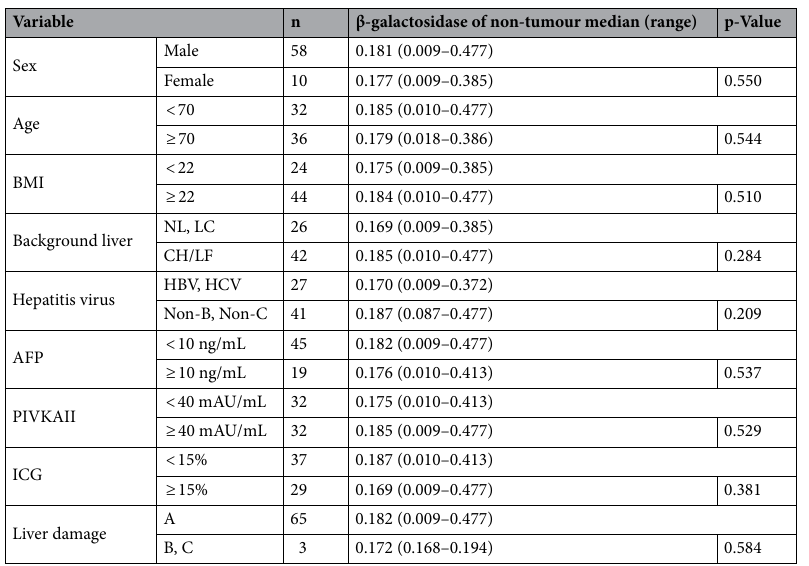
Table 2. Association between clinicopathological factors and β-galactosidase (β-Gal) activity in non-tumour liver parenchyma tissues. β-Gal activity in non-tumour liver parenchyma tissues was analysed in relation to clinicopathological factors. β-Gal activity in non-tumour was not significantly different when divided into two groups according to clinicopathological factors (sex, age, BMI, background liver, AFP, PIVKAII, ICG, and grade of liver damage). Data were analysed using a two-tailed Mann–Whitney U -test. BMI; body mass index, NL; normal liver, CH; chronic hepatitis, LF; liver fibrosis, LC; liver cirrhosis, Non-B; patients not infected with HBV, Non-C; patients not infected with HCV, AFP; alpha-fetoprotein, PIVKAII; protein induced by vitamin K absence or antagonist-II, ICG; indocyanine green. Liver damage was defined based on the General Rules for the Clinical and Pathological Study of Primary Liver Cancer, Edition 6, Revised Version 35